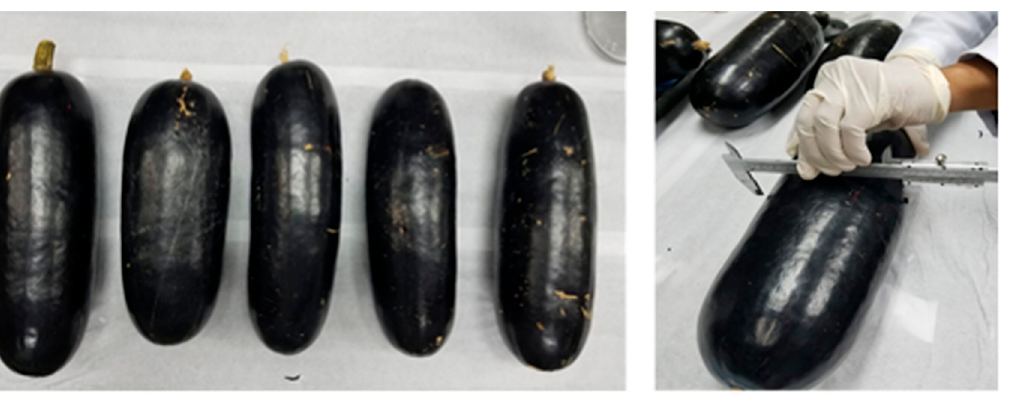
Figure 1. Morphological characters of the fruit of S. odorifera in ripe state.